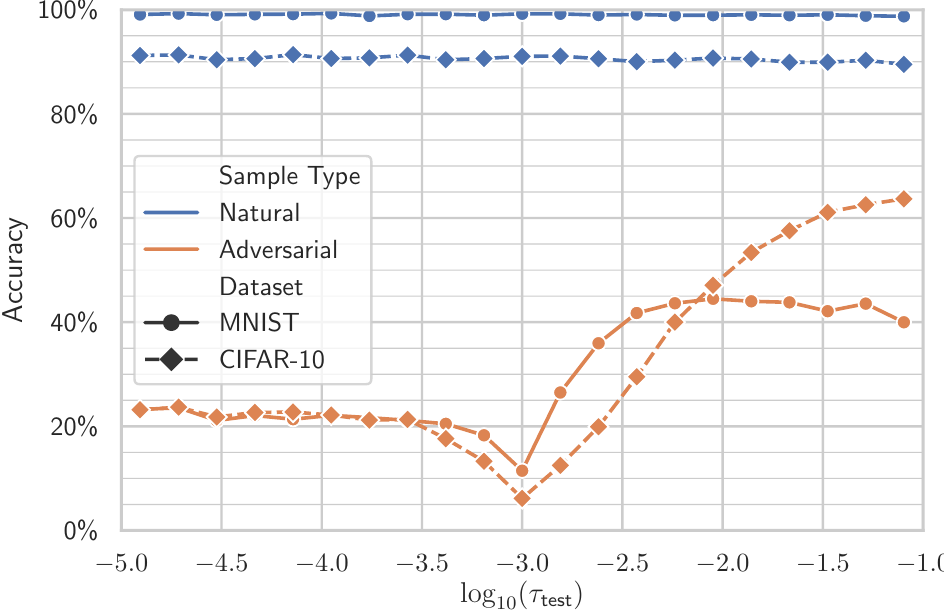
Figure 3. Accuracy vs. test-time solver tolerance τ test . For each image, we sampled 20 values for τ from a log-uniform distribution within the [ 10 − 5 ,10 − 1 ] interval. We report the mean accuracy of the ODENet classifier on natural and adversarial examples for each tolerance bin (in log space, points’ x -coordinates indicate the bin